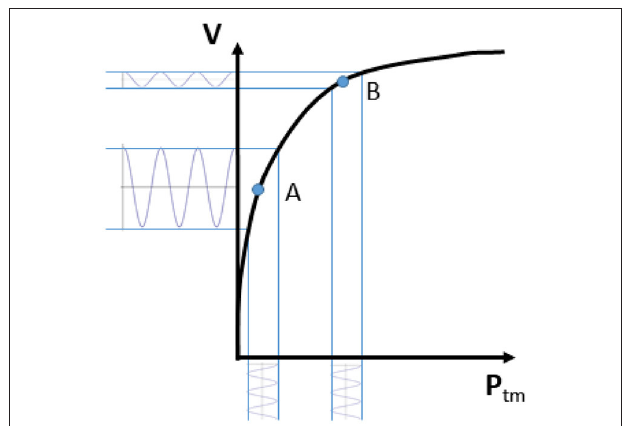
FIGURE 1 | Volume-pressure curve of a venous blood vessel relating the vessel size (volume V ) to the transmural pressure ( P tm ). Note that an oscillatory perturbation in blood pressure results in large volume changes if P tm is low (A; high vessel compliance) and low pulsatility if P tm is high (B; low vessel